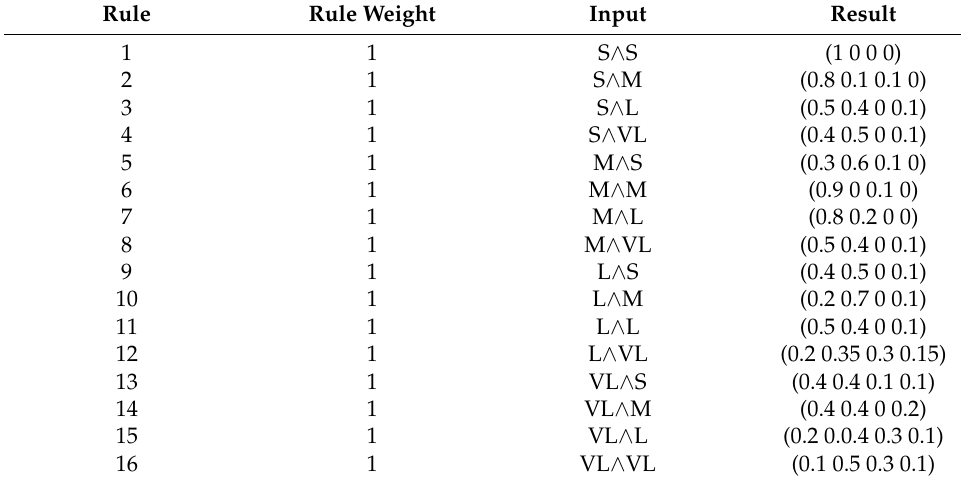
Table 6. Initial parameters of BRB1.